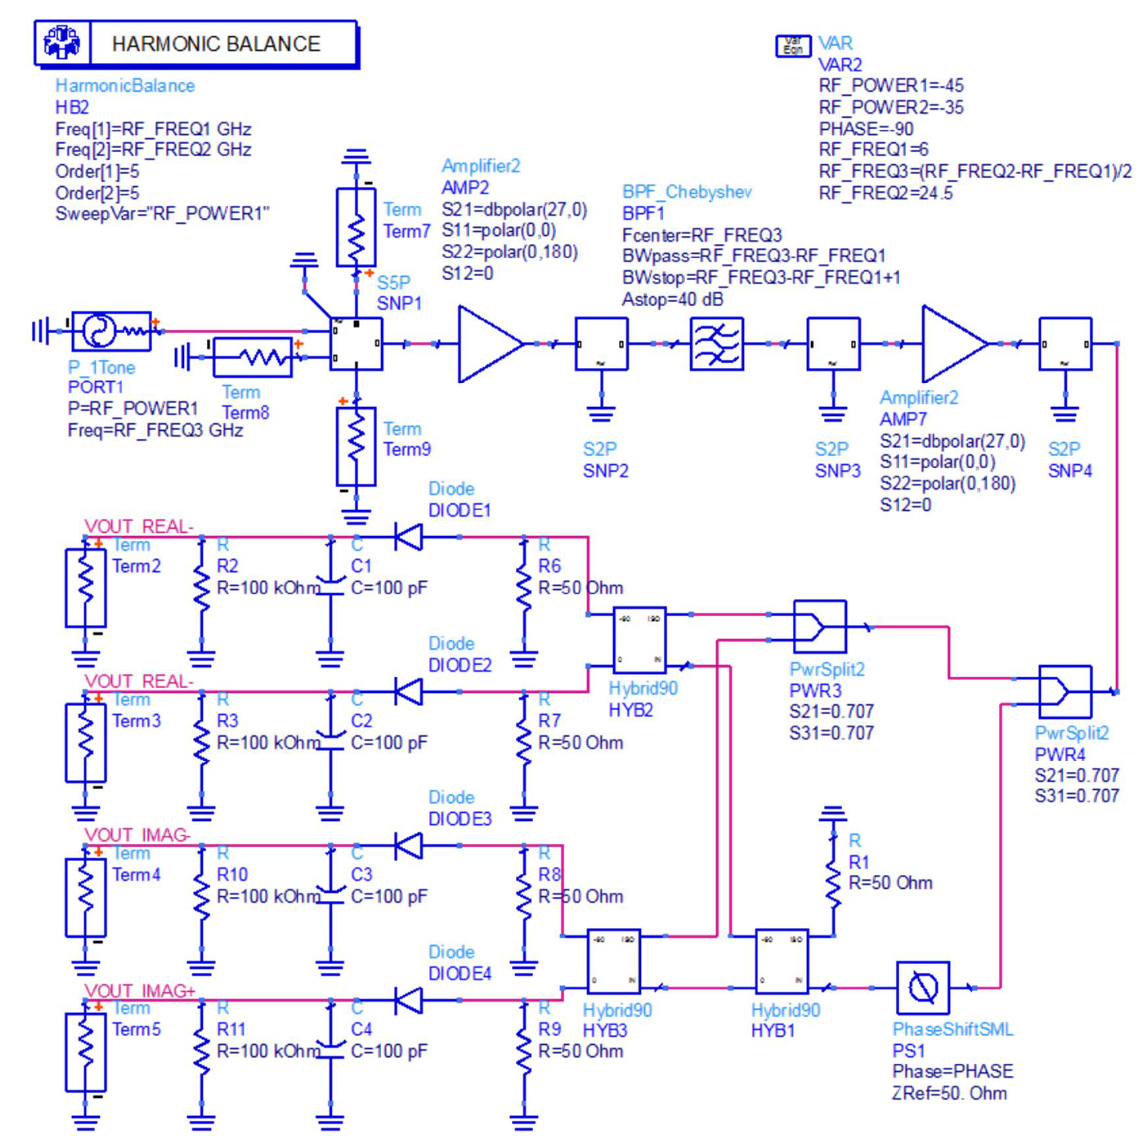
Figure 10. Schematic diagram of full-power microwave radiometer simulation.